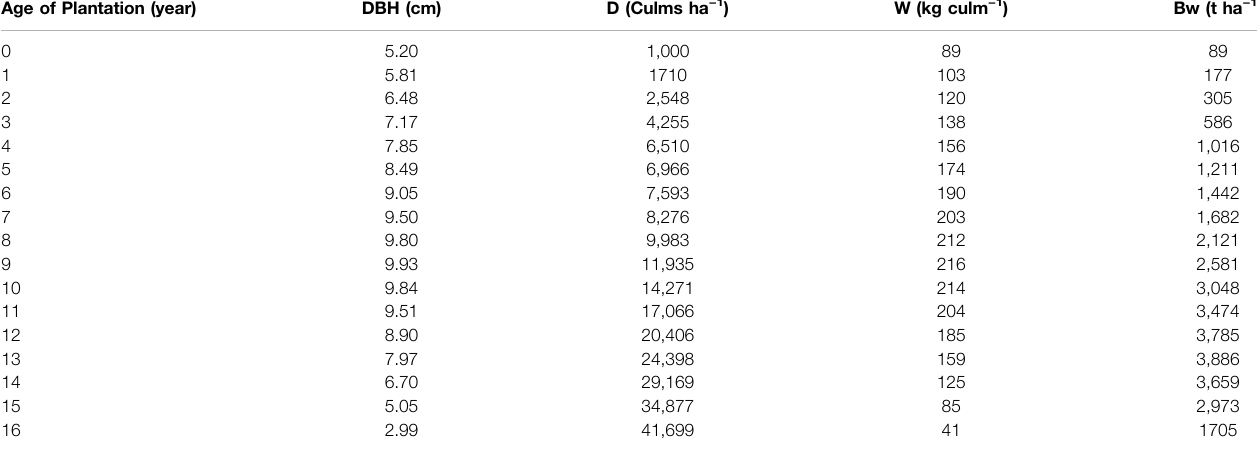
TABLE 1 | Correlation of diameter at breast height (DBH) and density (D) with the amount of above ground biomass of each culm (W) and of each unit of land (Bw). Age of Plantation (year) DBH